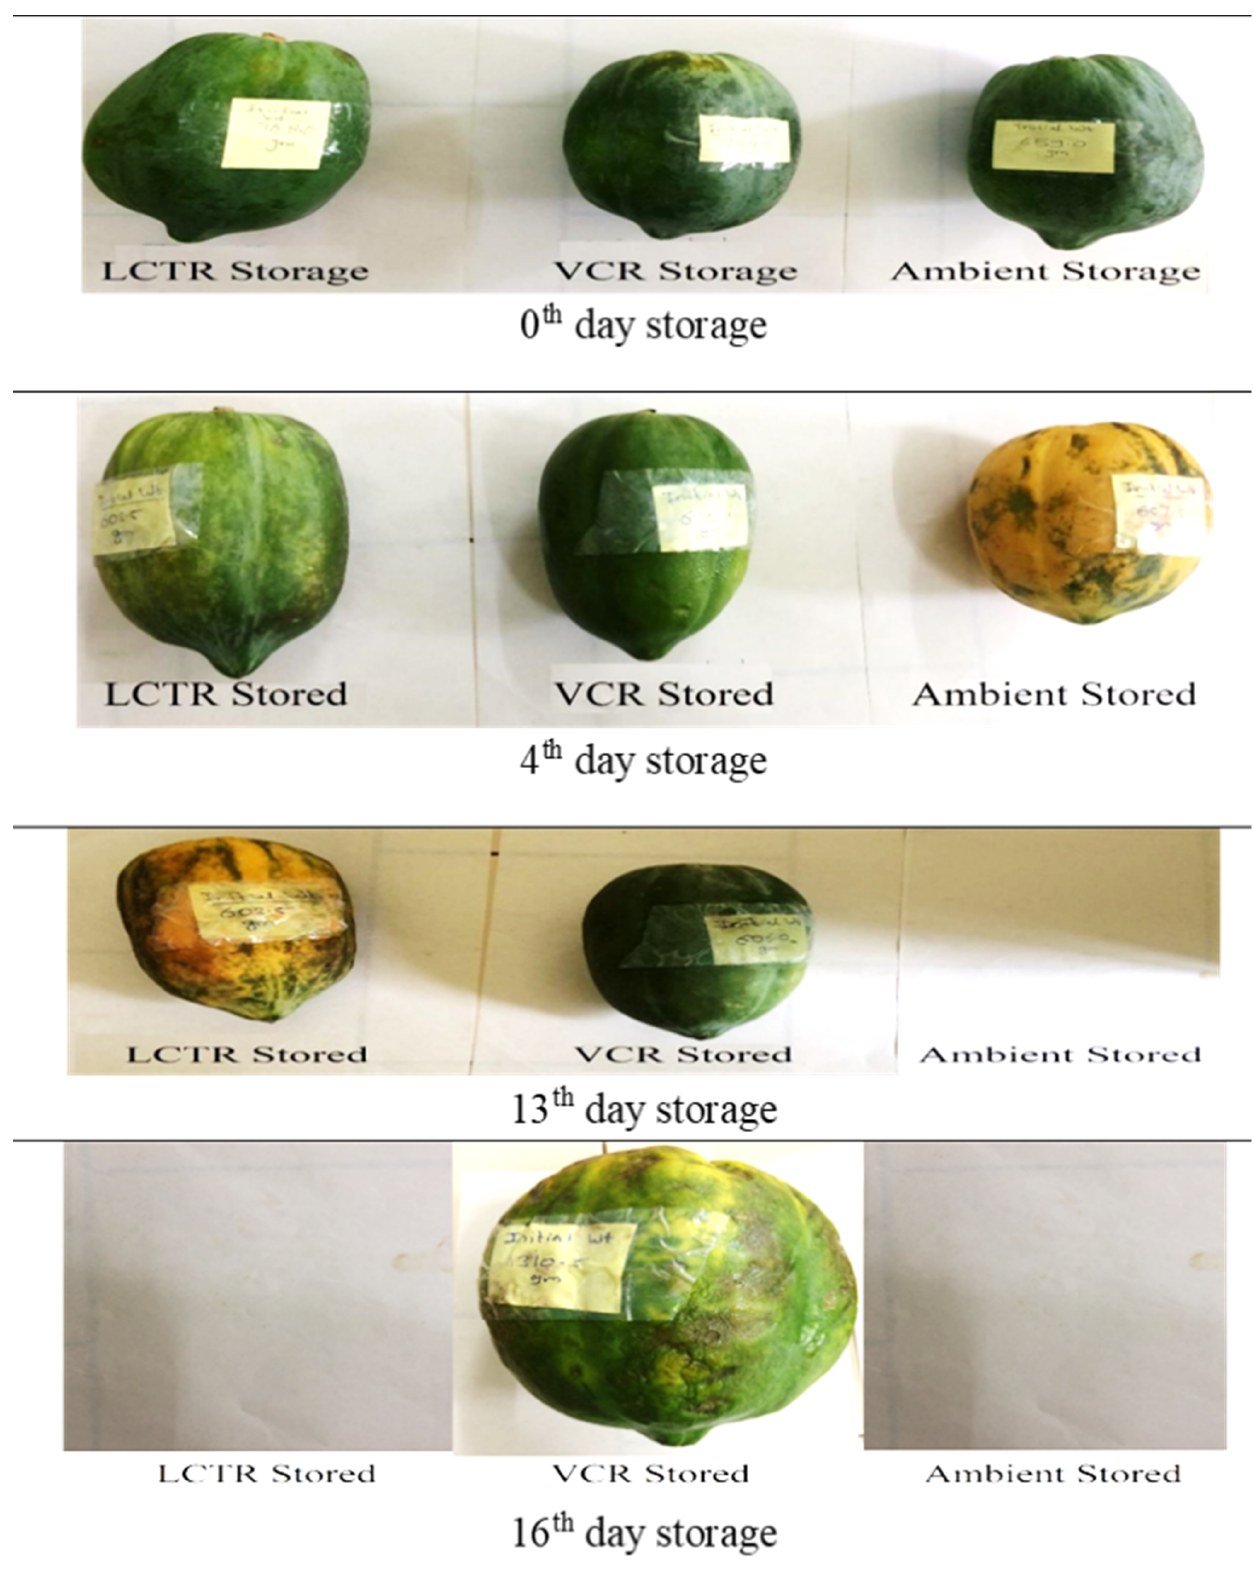
Figure 9. The visual appearance of papaya during storage. An analysis of variance (ANOVA) for average daily change of colour value ‘a’ re- vealed that colour value ‘a’ was significantly influenced by storage condition ( p < 0.0001) as well as crop species ( p = 0.0091) at a 5% level of significance. The diffogram (Figure 10) generated from ANOVA also indicated that no significant difference of average daily change of colour value ‘a’ existed among LCTR and VCR storage conditions, whereas the